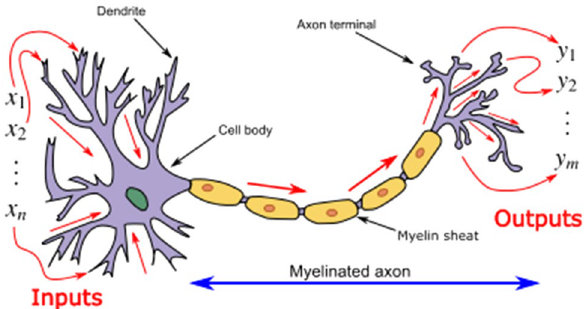
Fig. 13 The general configuration of neurons